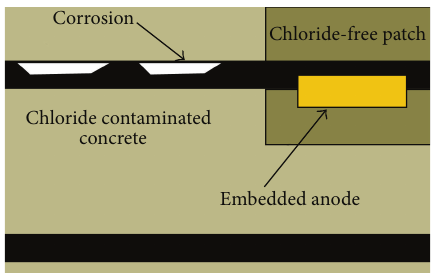
Figure 1: Corrosion cell in concrete.